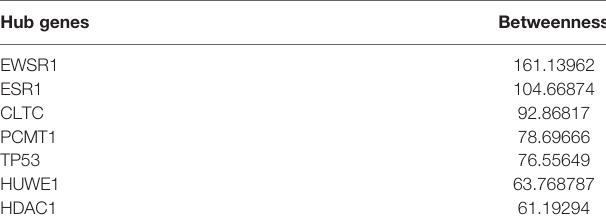
TABLE 1 | Betweenness (BC) from high to low ranking of the seven hub genes. Hub